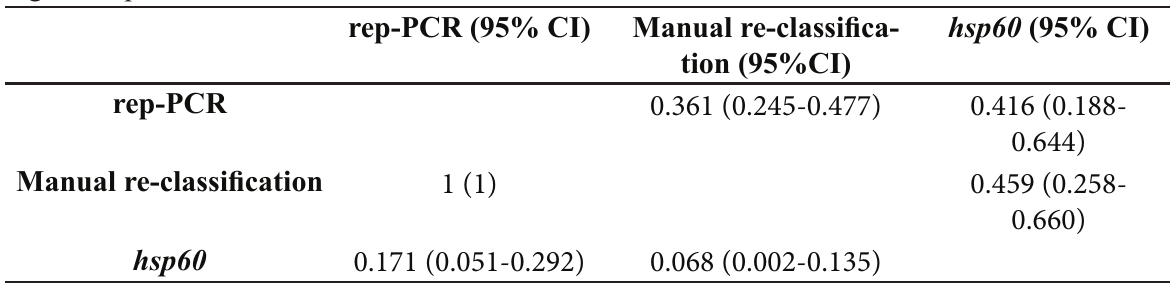
Table 2. Adjusted Wallace Coefficient and 95% Confidence Intervals (CI) within hsp60 sequenc- ing and